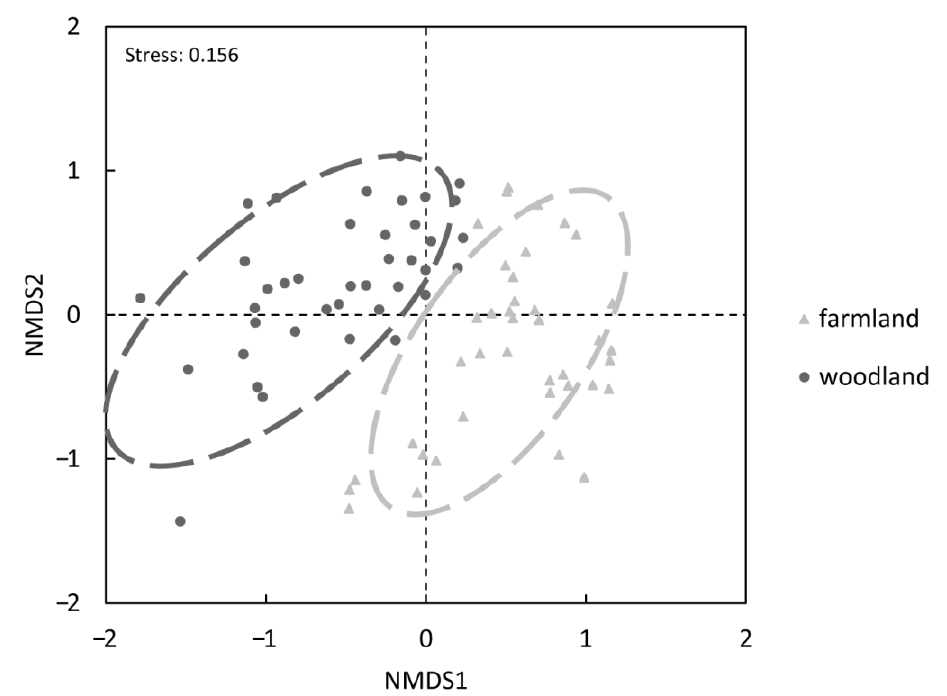
Figure 5. Non-metric multidimensional scaling (NMDS) ordination of arbuscular mycorrhizal fungal community composition in farmland and woodland. Table 2. PERMANOVA (permutational multivariate analysis of variance) based on Bray-Curtis distance showing the dissimilarity of AMF communities between farmland and woodland. df Sums of Squares Mean Squares